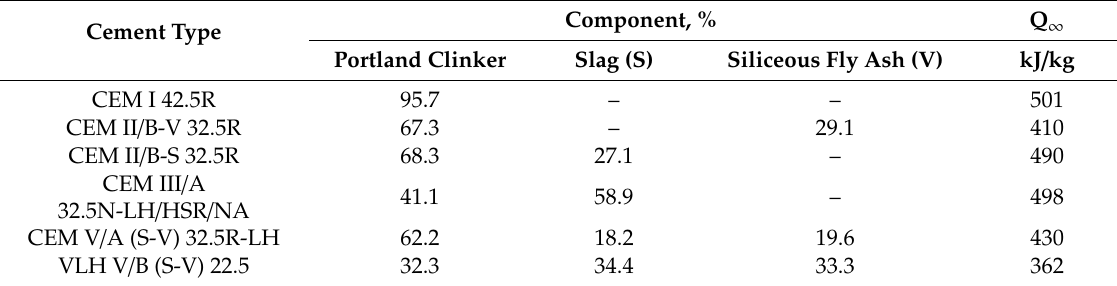
Table 2. Total heat of cement hydration calculated based on Equation